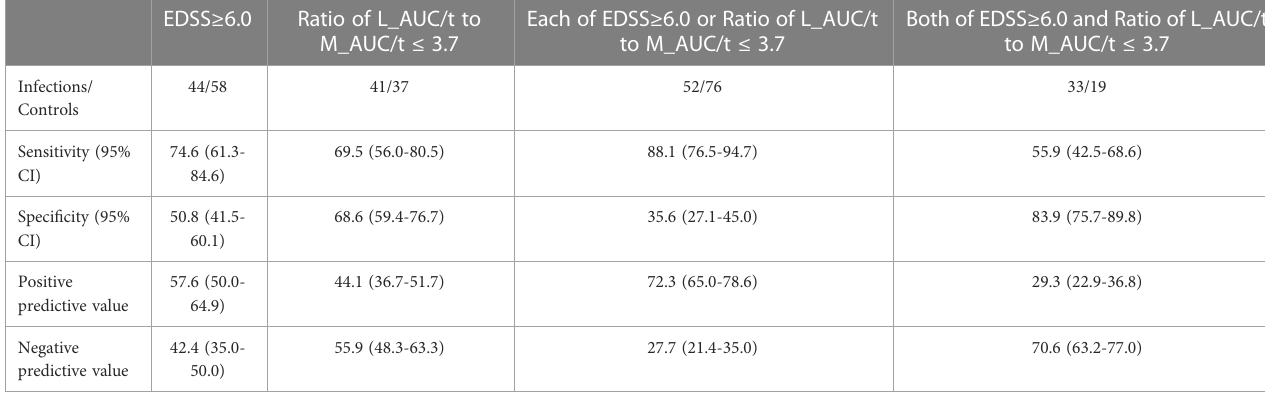
TABLE 4 Discriminate analysis for infection group and controls by using EDSS or Ratio of L_AUC/t to M_AUC/t. EDSS ≥ 6.0 Ratio of L_AUC/t to M_AUC/t ≤